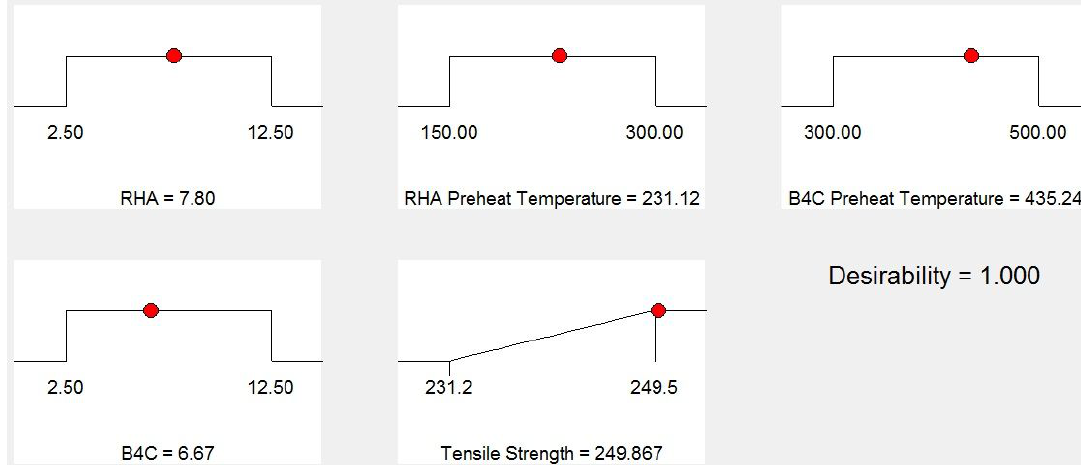
Figure 9: Ramp function